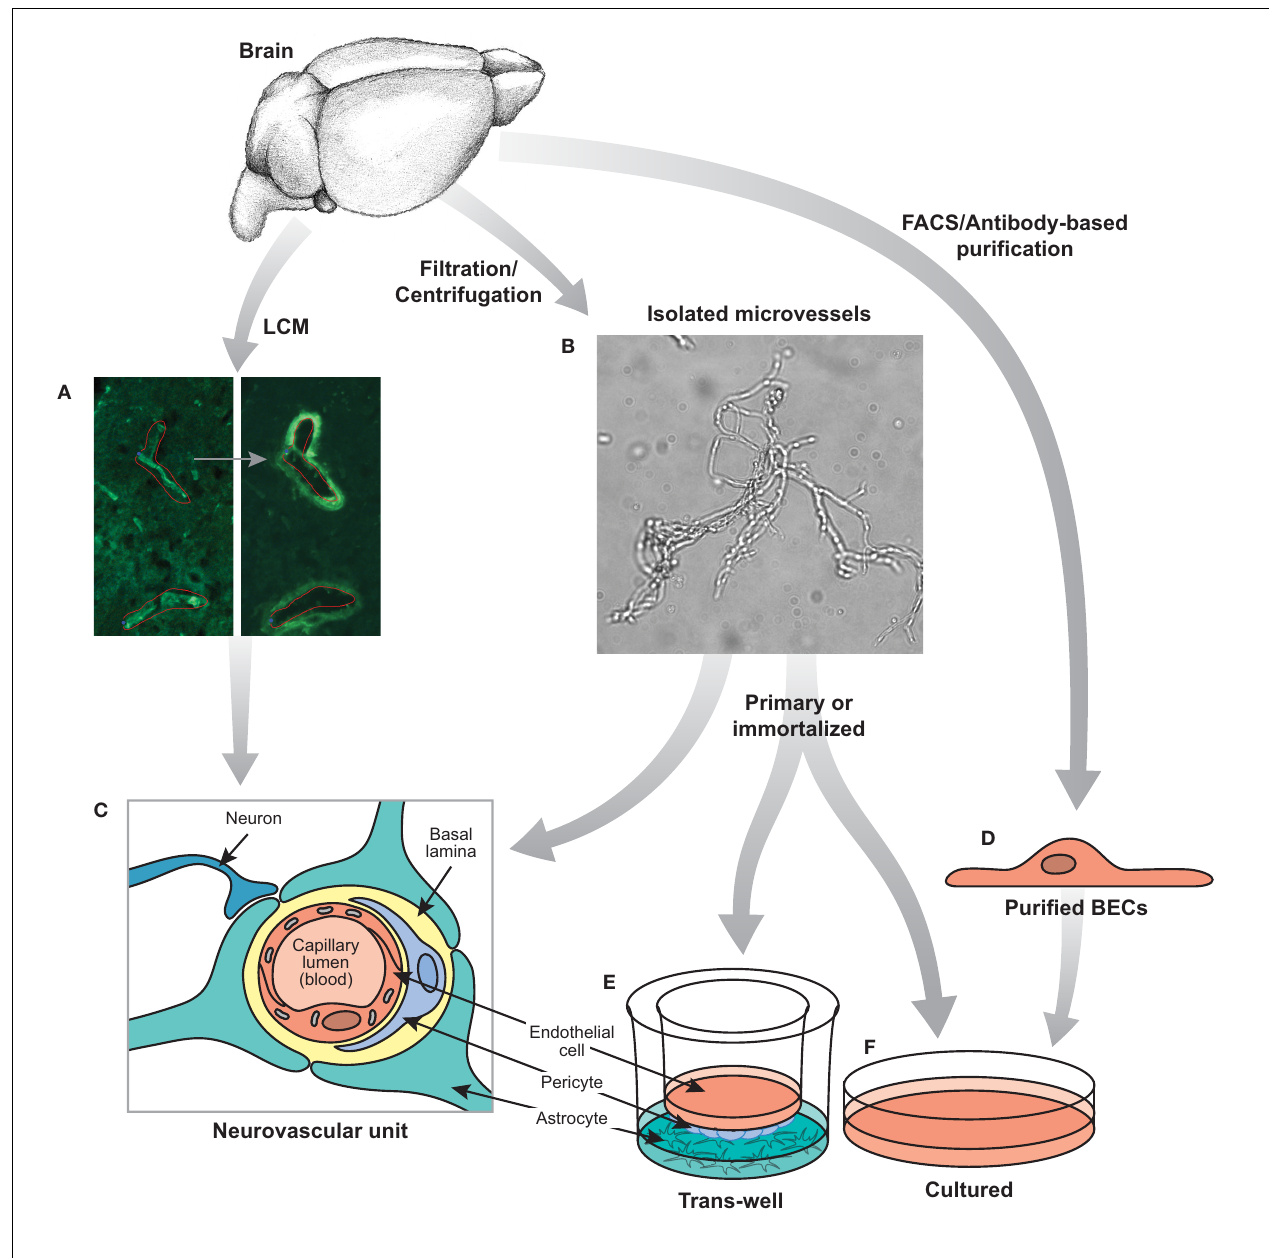
FIGURE 1 | Techniques for isolating BECs. (A) Laser capture microdissection or (B) mechanical filtration of brain microvessels can be used to isolate segments of the neurovascular unit (C) . FACS or other antibody based purification (D) can be performed to isolate BECs acutely. Isolated